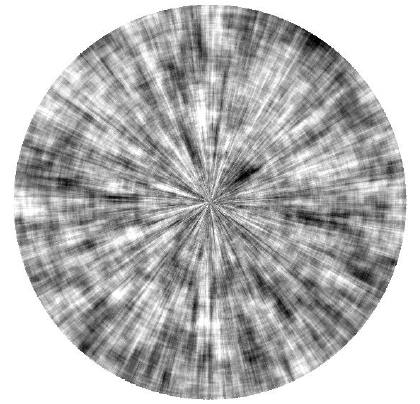
Figure 9. The image with radial correlation